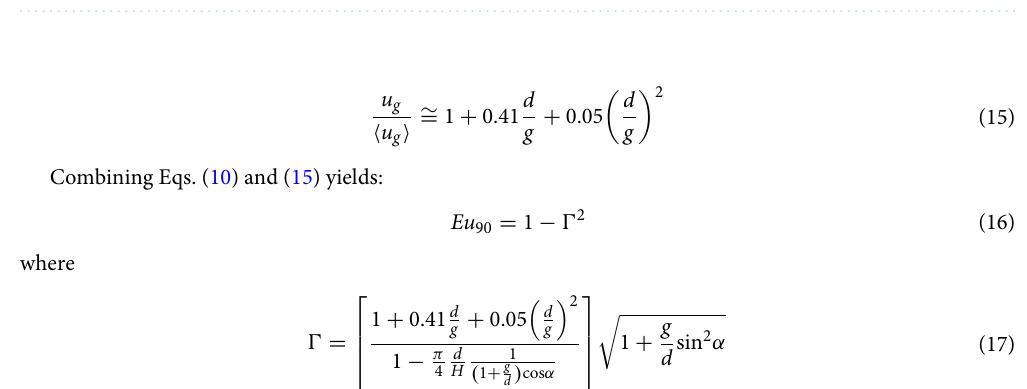
Figure 10. Wall Euler number at θ = 90 o . The curve corresponds to Eq. (16). Created with Gnuplot 5.4, www. gnupl ot.